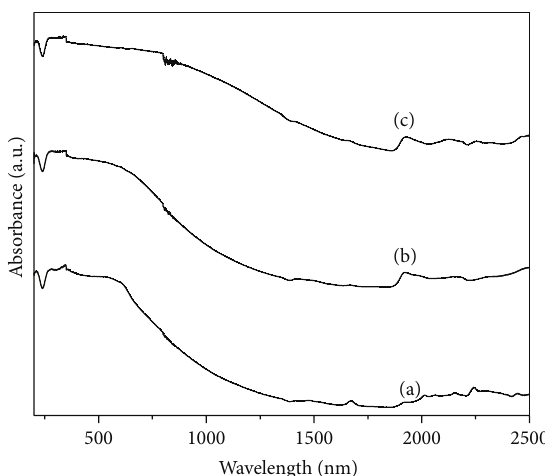
Figure 1: UV-VIS-NIR spectra of isomers of aminophenol: (a) PoAP, (b) PmAP, and (c) PpAP.